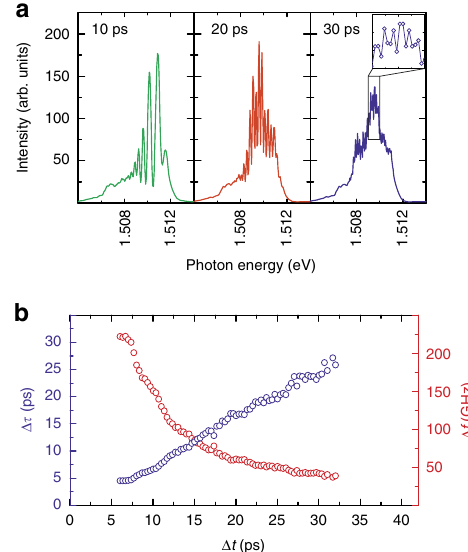
Figure 2 | Fringe spacing versus pump–probe delay. ( a ) Selected optical spectra recorded from the NW laser subject to a pump pulse in the lasing regime and a probe pulse in the ASE regime (L-ASE) for D t ¼ þ 10ps (green), D t ¼ þ 20ps (red) and D t ¼ þ 30ps (blue). The inset shows a zoom-in of the spectrum, demonstrating that modulation is still observed and that the spacing is close to the resolution limit. ( b ) Repetition rate (red circles) and NW laser pulse separation (blue circles) as a function of D t , measured from the separation of the interference fringes in the NW laser spectra and their inverse in a , respectively.